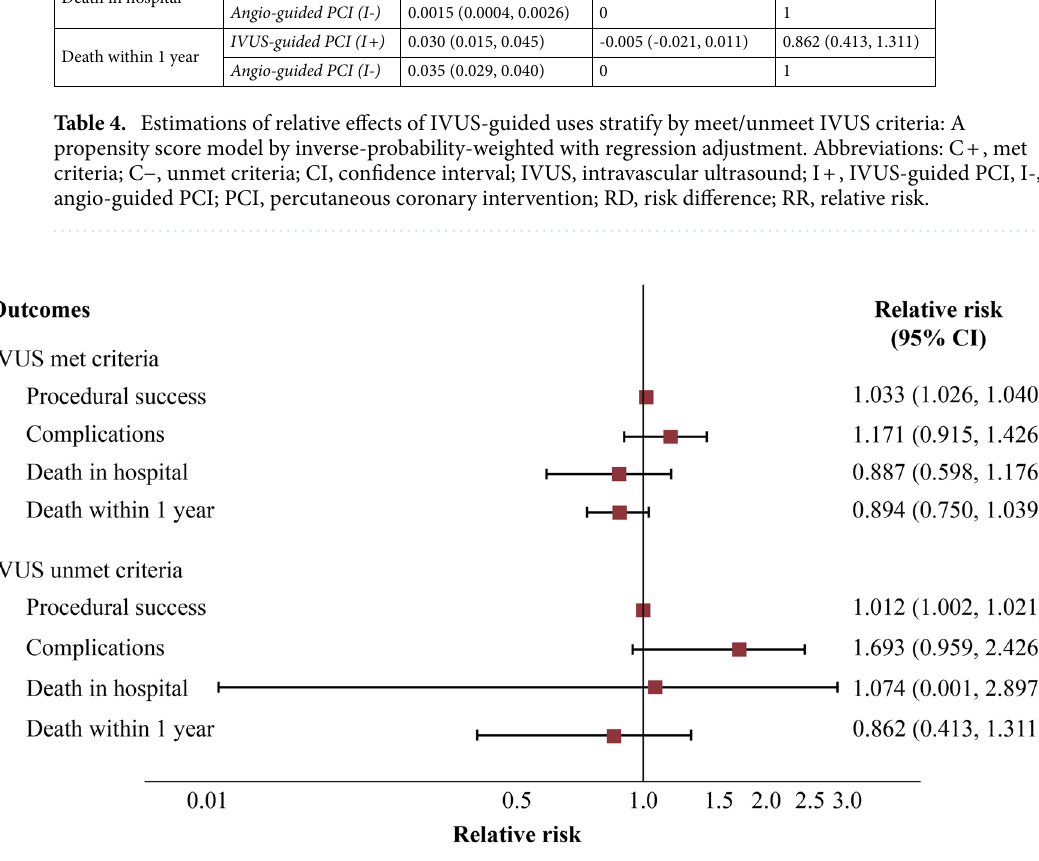
Figure 3. Relative risks of the primary and secondary endpoints by IVUS criteria groups: A propensity score analysis. Abbreviations: CI, confidence interval; IVUS, intravascular